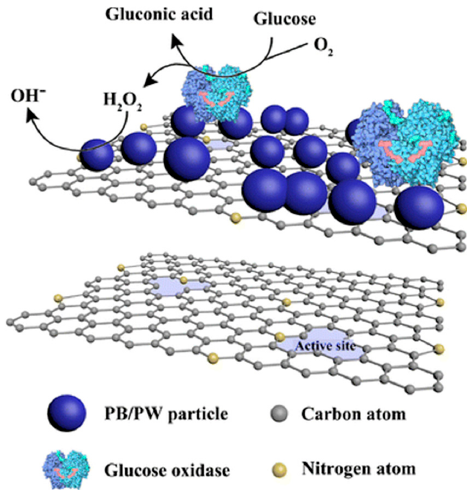
Figure 2. An example of using nanomaterials coupled with Prussian Blue (PB) to develop a PB-based enzymatic biosensor. PB and PW stand for Prussian Blue (Fe 4 [Fe(CN) 6 ] 3 ) and Prussian White (K 4 Fe 4 [Fe(CN) 6 ] 3 ). Adapted with permission from [41], copyright 2018, Springer Nature.